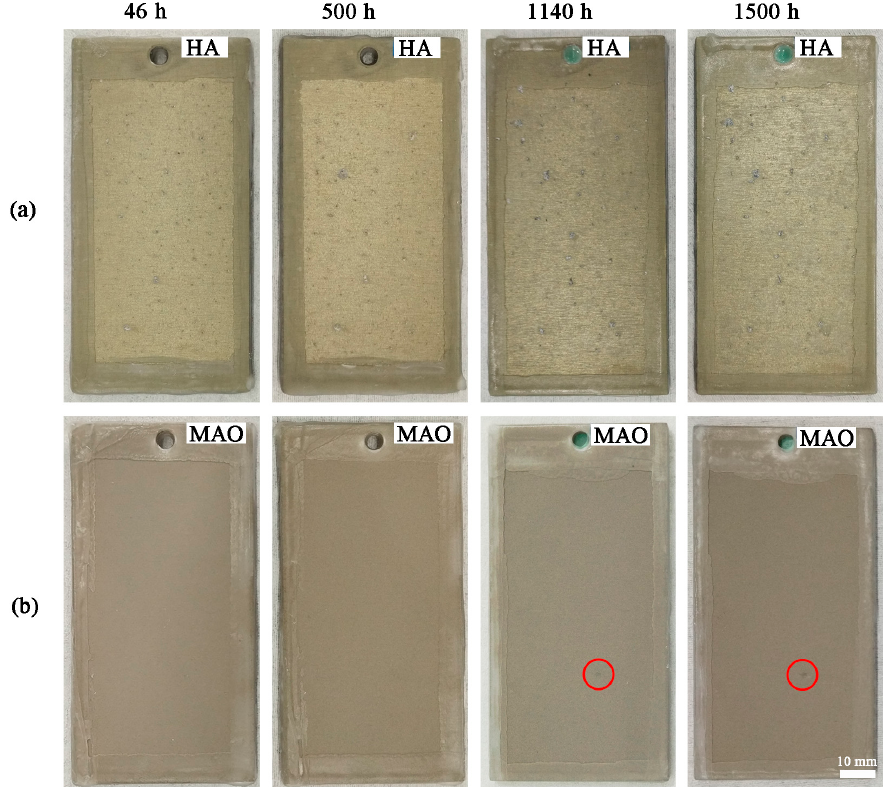
Figure 8. Photographs of the HA- ( a ) and the MAO-treated ( b ) 7050 Al alloy after a neutral salt spray test (NSST) for different times.